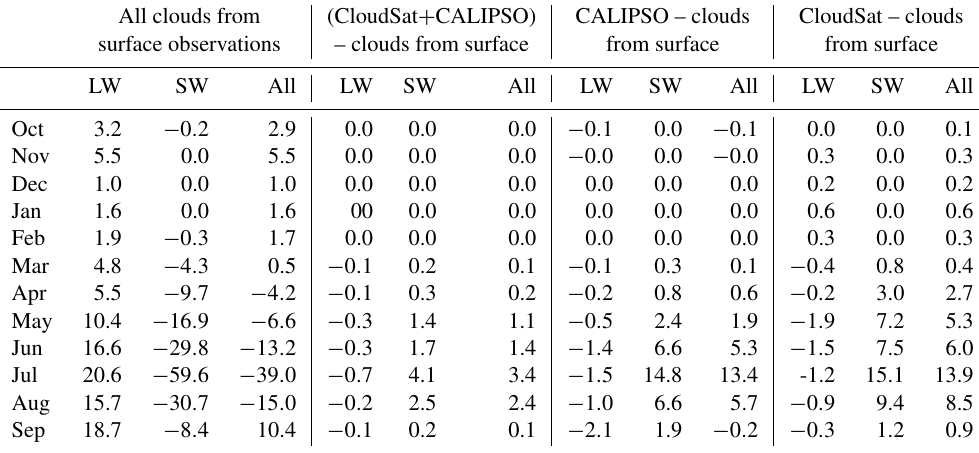
Figure 14. Scatterplots of shortwave cloud radiative forcing at the surface using clouds from surface observations and clouds identified by combined CloudSat and CALIPSO and cloud optical thickness of omitted (a) all clouds, (b) ice clouds, (c) liquid clouds, and (d) mixed-phase clouds below 1km during the SHEBA experiment. Table 2. Monthly mean CRF at the TOA for longwave (LW), shortwave (SW), and the combined LW and SW (all) with the clouds from the surface observations collected during the SHEBA experiment and the differences between the CRF with clouds in the surface observations only identified from combined CloudSat and CALIPSO, CALIPSO, or CloudSat and the CRF from the clouds from the surface observations. All clouds from (CloudSat + CALIPSO) CALIPSO – clouds CloudSat –